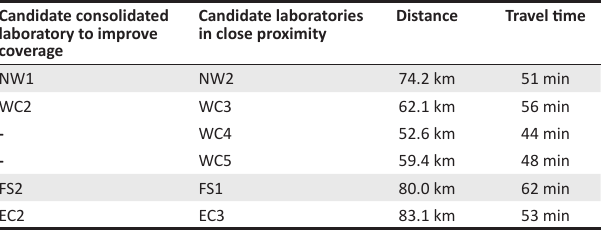
TABLE 2: Google Maps distances and travel times between candidate laboratories in close proximity across the four clusters identified, South Africa. Candidate consolidated laboratory to improve